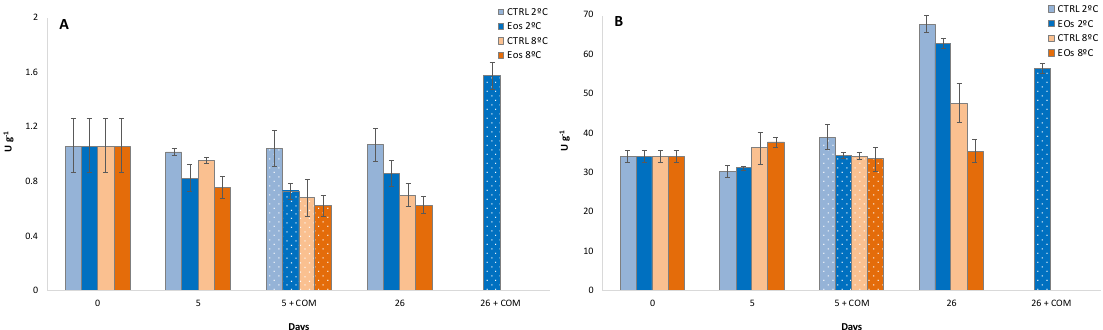
Figure 5. Endo-PG ( A ) and exo-PG ( B ) activities during cold storage periods (2 and 8 °C) and complimentary commercialization simulations (COM; 4 days at 22 °C) for flat peaches with or without active paper sheets (including βCD-encapsulated EOs) ( n = 3 ± SD).